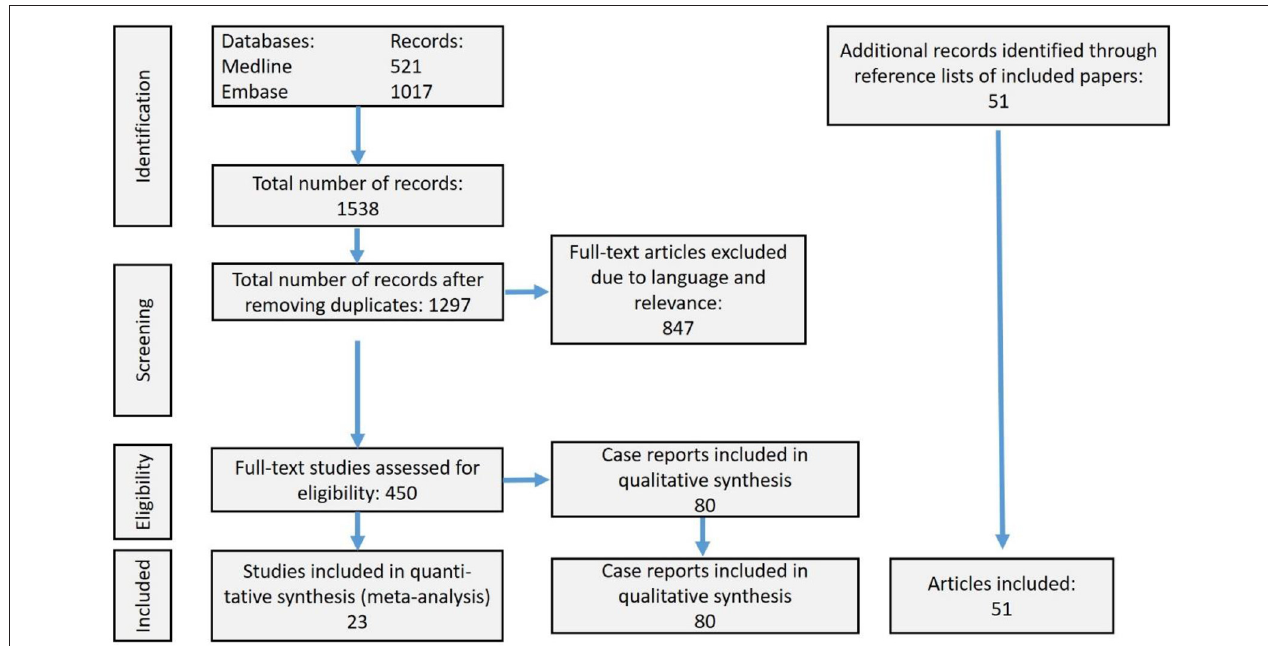
FIGURE 2 | Prisma flow-chart displaying the literature search history. Of totally 1,538 references, we included 23 observational studies of patients with hypothermic cardiac arrest, who underwent attempted resuscitation with extracorporeal life support (ECLS) in the meta-analysis. Fifty-one articles lead up to the present review and meta-analysis and/or were used for discussion of our findings. Finally, we addressed 80 case reports.